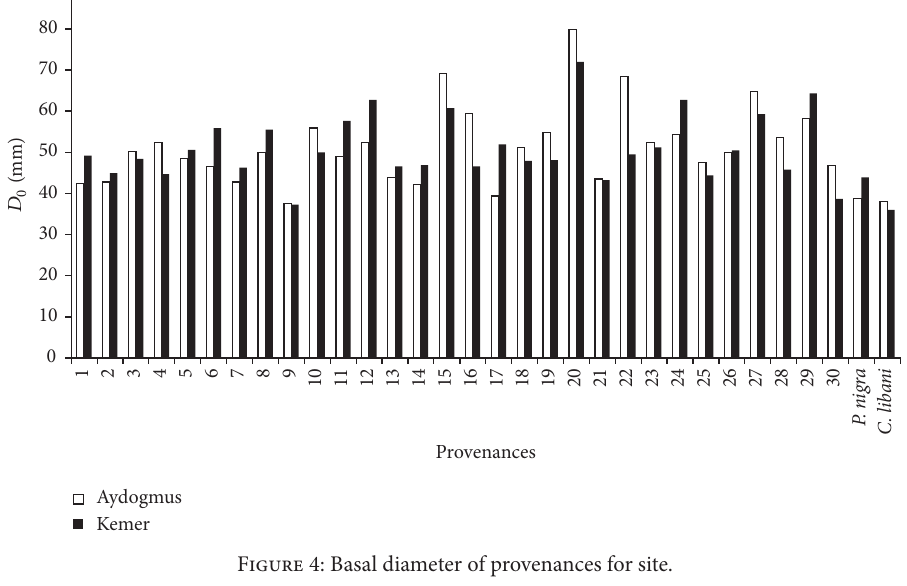
Figure 4: Basal diameter of provenances for site.